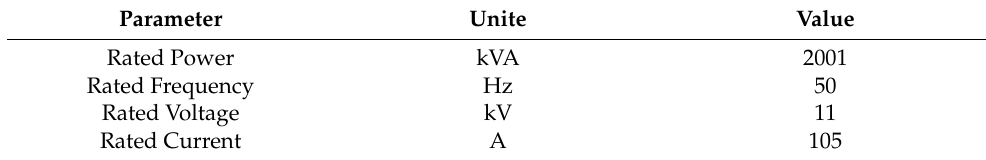
Table 2. Rated values of the tested synchronous machine. Parameter Unite Value Rated Power kVA